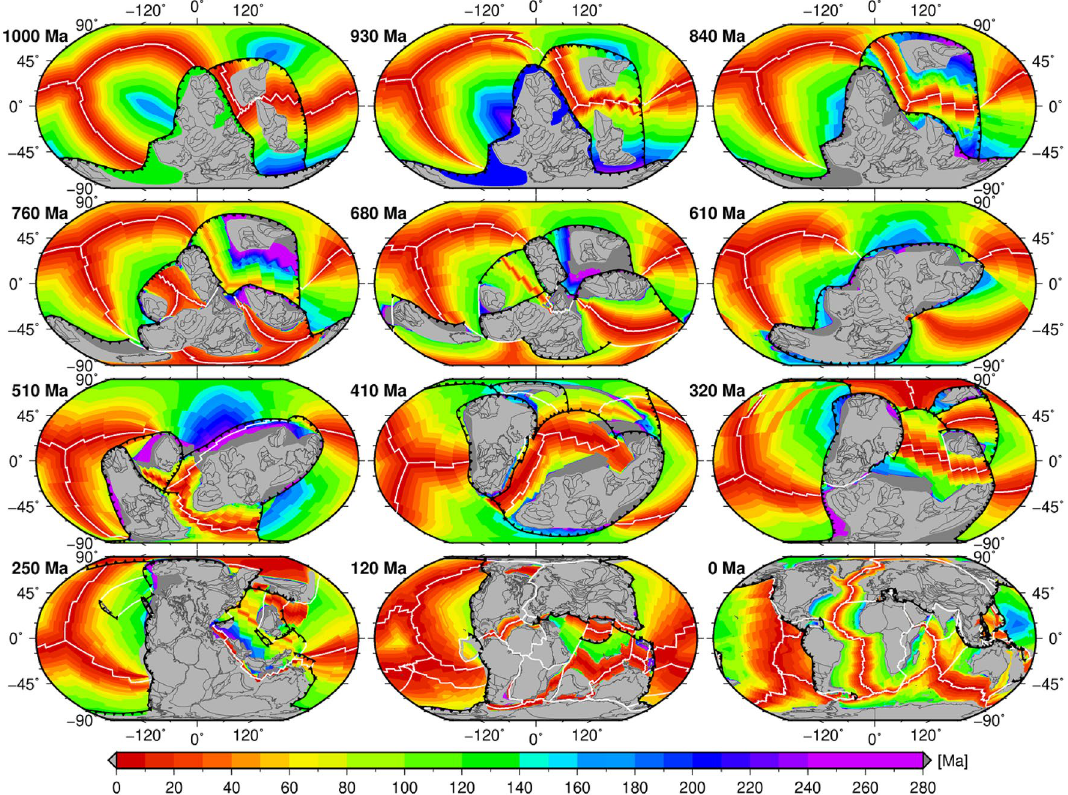
Figure 1. Synthetic plate reconstructions since 1000 Ma (plate motion model NNR from Cao et al. 38 ). The 1000–250 Ma part is synthetic, and the 250–0 Ma part is from Young et al. 40 . Three supercontinents assemble by introversion, and exist between 900 and 800 Ma (first supercontinent), 620–600 Ma (second supercontinent) and 320–200 Ma (Pangea), respectively. The colour scale shows ocean floor age. Mid-ocean ridges are shown as white solid lines, subduction zones as toothed black lines. This figure was created using the Generic Mapping Tools version 4.5.5 (https:// www. gener ic- mappi ng- tools. org/) 85